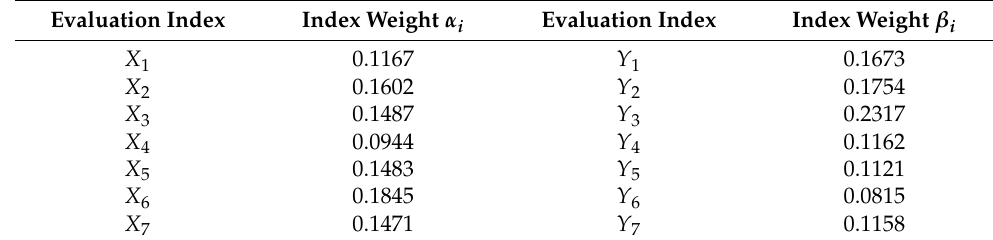
Table 14. China and Germany “coal phase-out” related index weight